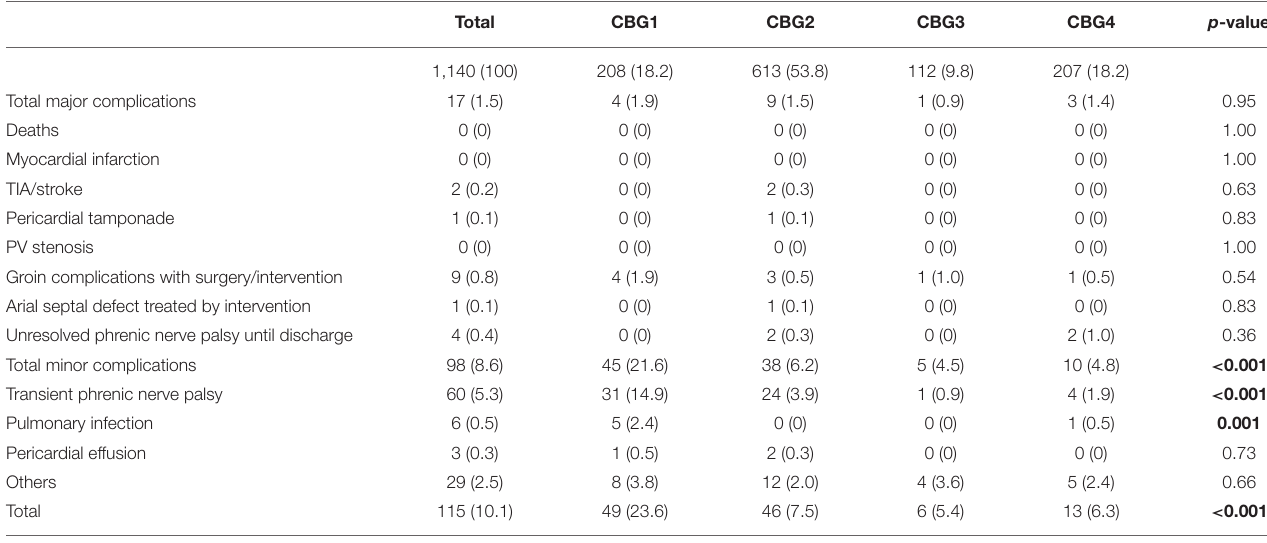
TABLE 3 | Complications and differences in the treatment